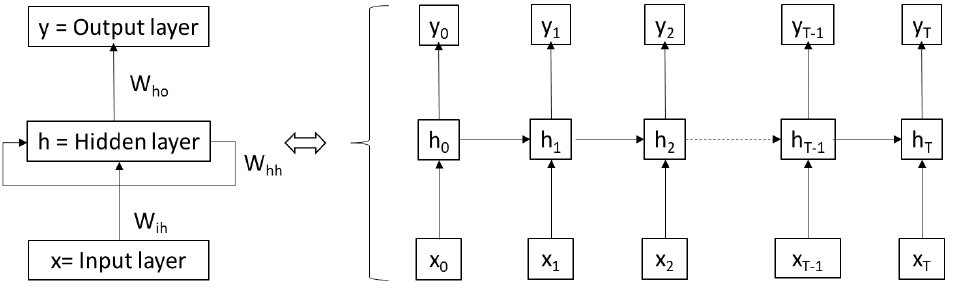
Figure 2. Schematic and simplified structure of an RNN.